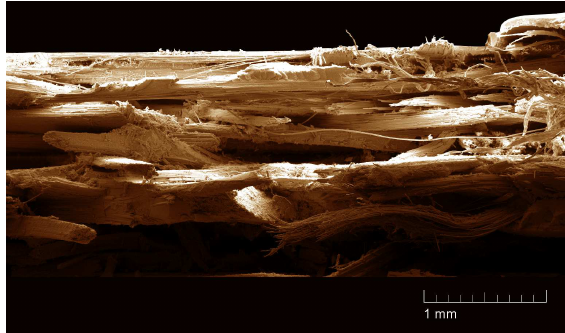
Figure 1. Detail of damaged structure obtained by scanning electron microscope, the plies are consisted of yarn with individual 5 µ m